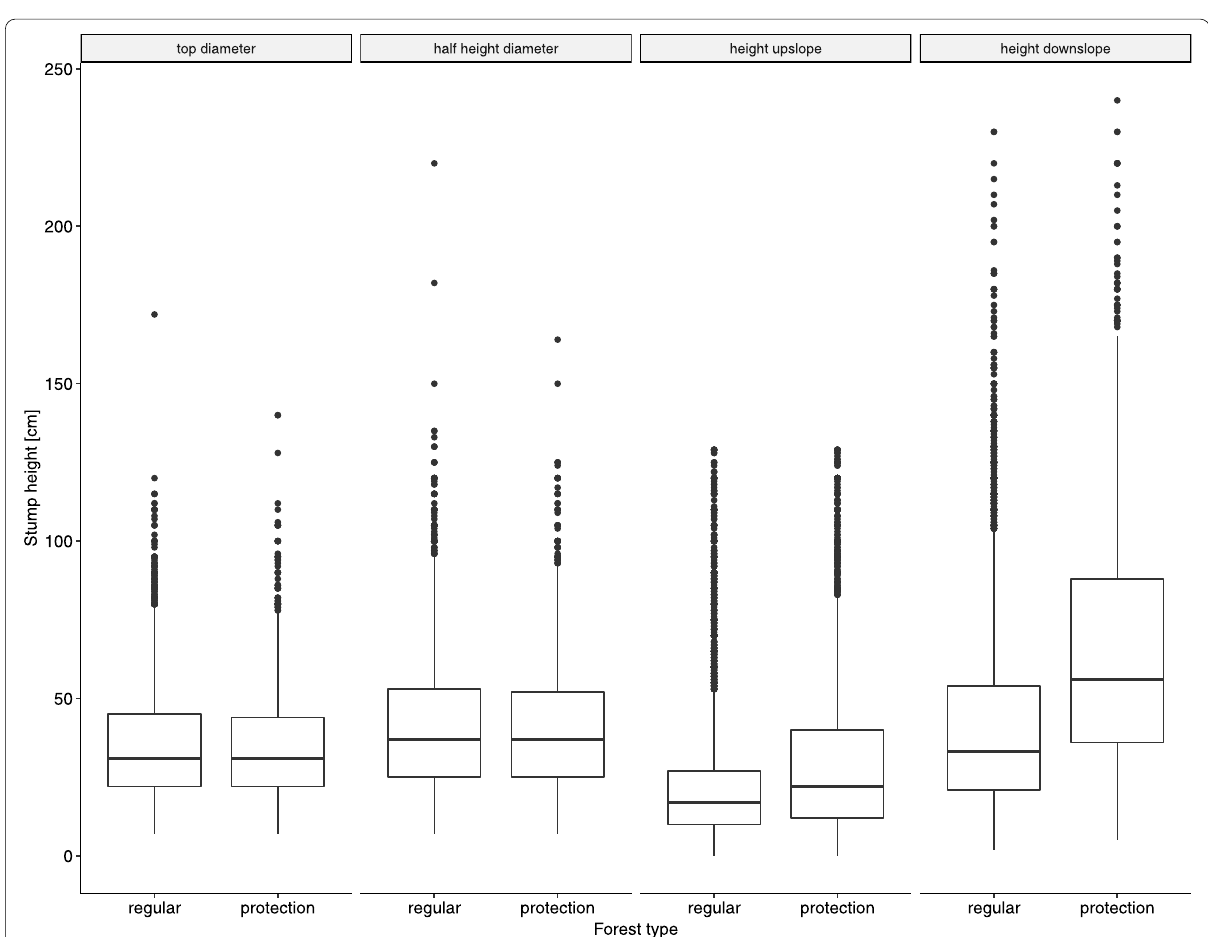
Fig. 9 Boxplots for stump height measured up- and downslope and diameter at the top and at half the downslope height in regular and protection